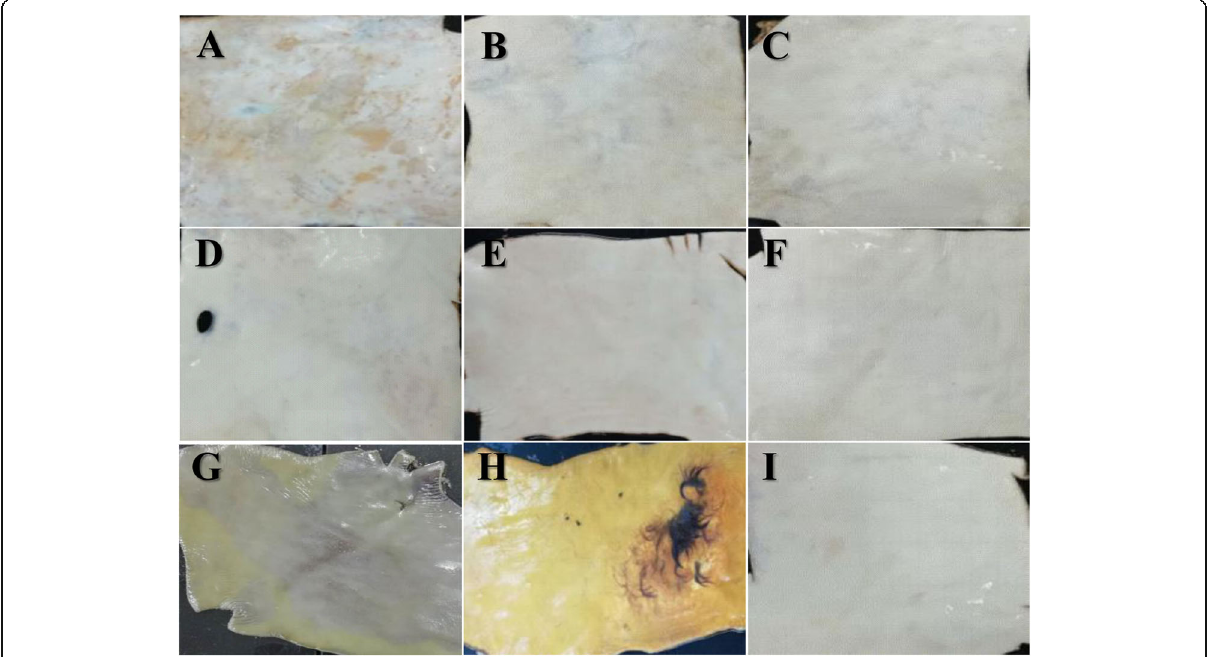
Fig. 5 The appearance of unhaired pelt by digital camera. ( a Cu(II); b Al(III); c Fe(III); d Adipate; e Laurate; f Salicylate; g Gallate; h ECG; i Proteinase K)